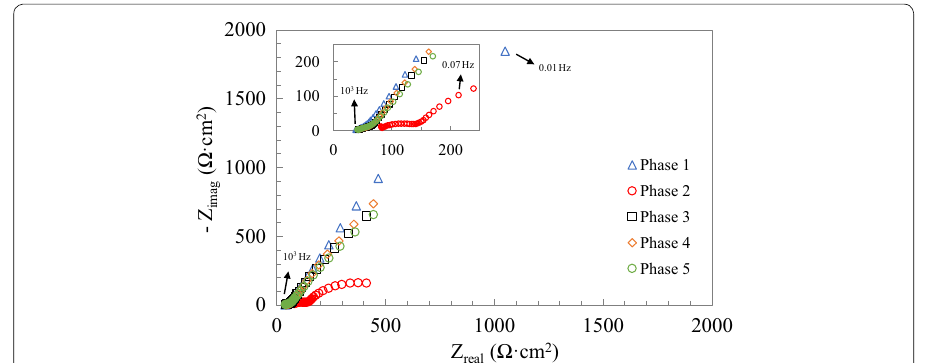
Fig. 6 Electrochemical impedance spectra of the API L80 carbon steel specimens exposed to the testing solution at different temperatures and oxygen concentrations. The spectra shown were obtained during the measurement no.